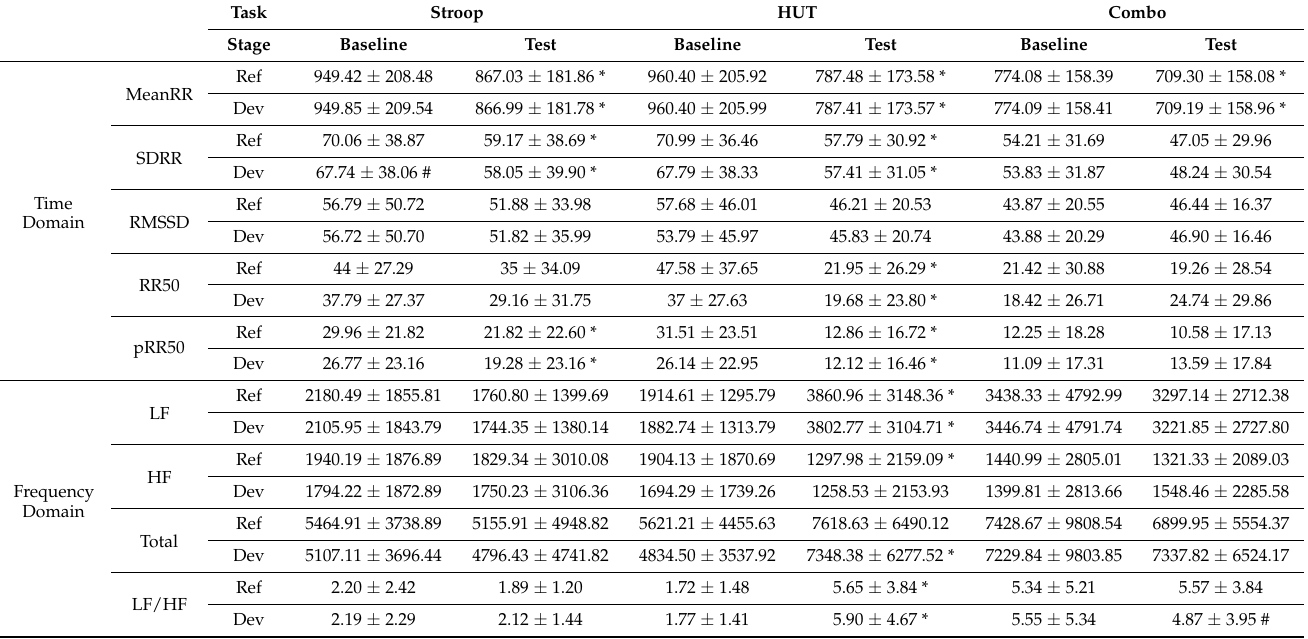
Table 4. Results for ECG